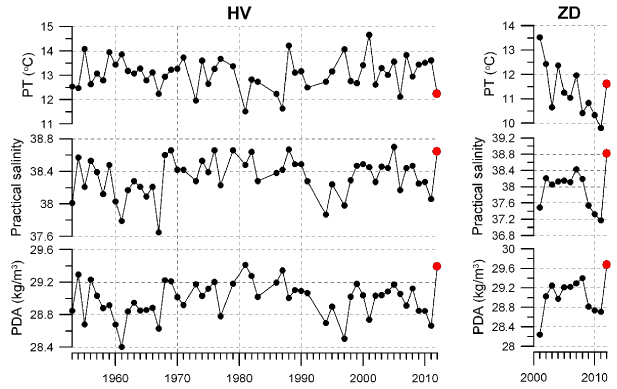
Fig. 6. Long-term series of potential temperature (PT), practical salinity and potential density anomaly (PDA) collected at stations HV and ZD (see Fig. 1 for station locations), at the maximum den- sity level between 1 February and 1 April. These dates are chosen as the maximum density in the deep Adriatic Sea occurs during this interval. Red circles denote the year